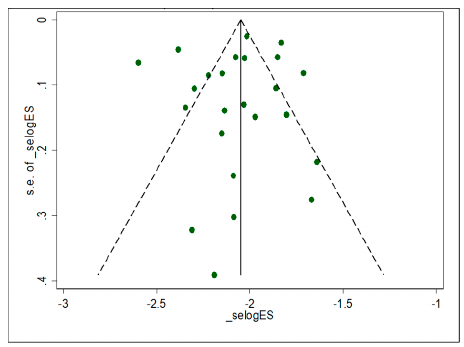
Figure 2. Funnel plot with pseudo 95% confidence limit of individual study estimates attributed with prevalence of malaria and helminthic co-infection among pregnant women in sub-Saharan Africa.